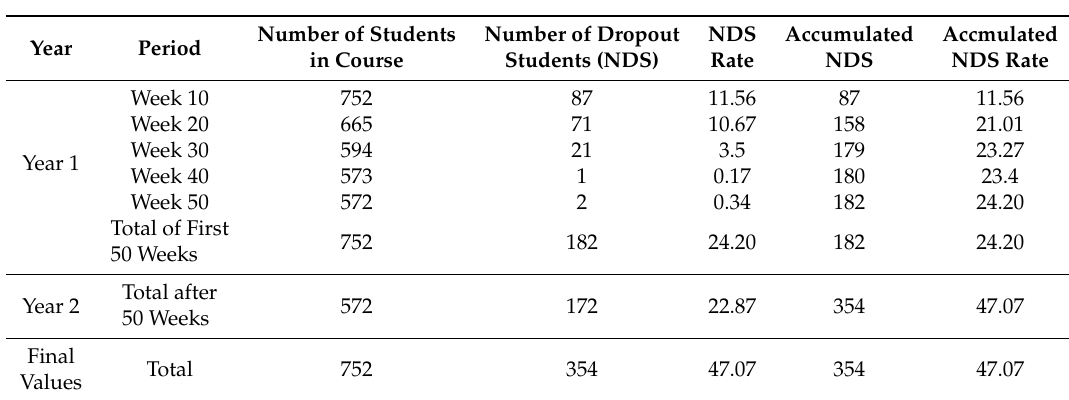
Table 4. Evolution of dropout during the